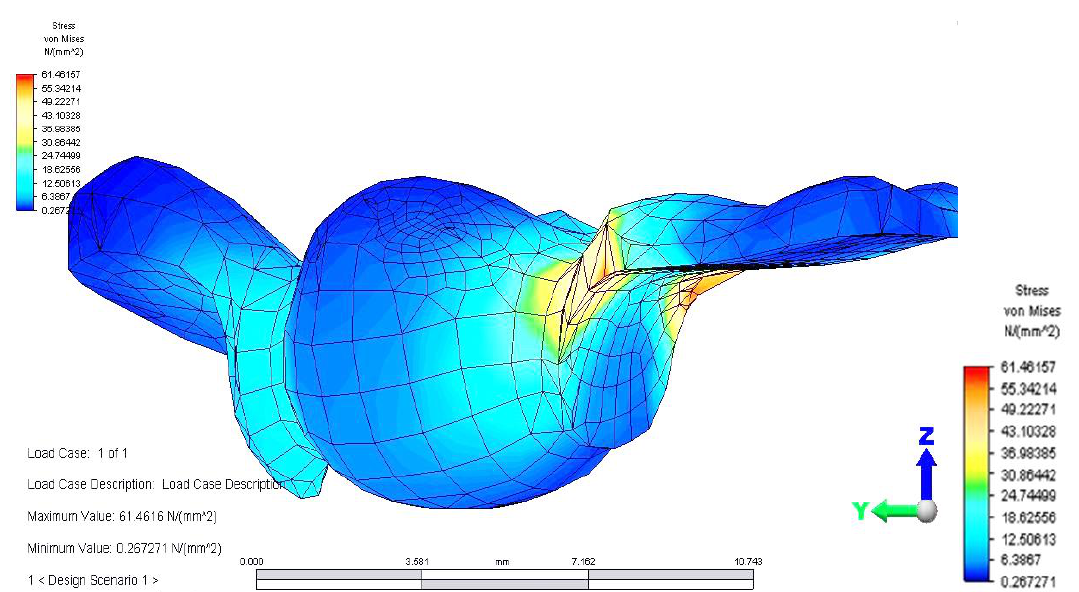
Figure 7. Tension distribution at the bridge level in three directions: axonometric, right and left, when the force is placed in the 3.6 area.